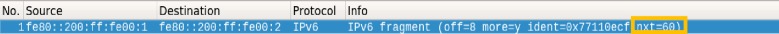
Host-B receives a non-first fragmented packet.